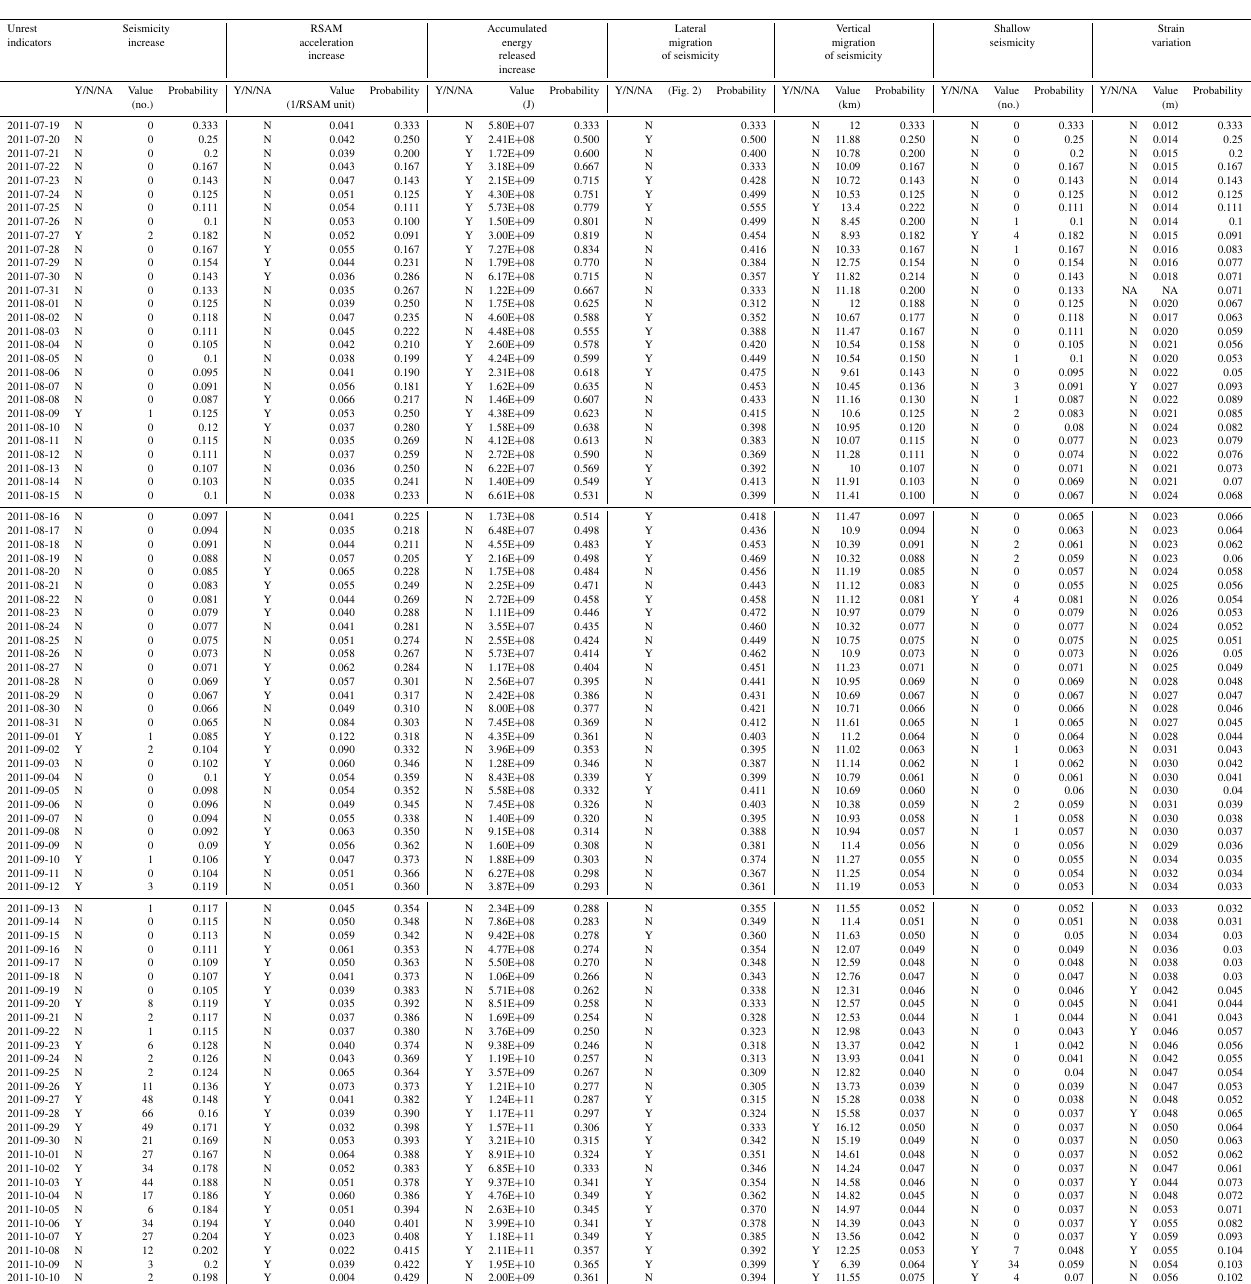
Table 1. Indicators during the unrest period. NA indicates not available. Unrest Seismicity RSAM Accumulated Lateral Vertical Shallow Strain indicators increase acceleration energy migration migration seismicity variation increase released ofseismicity ofseismicity increase Y/N/NA Value Probability